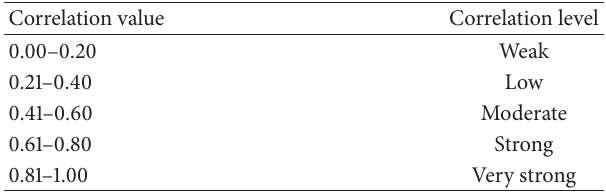
Table 5: Correlation value versus correlation level.